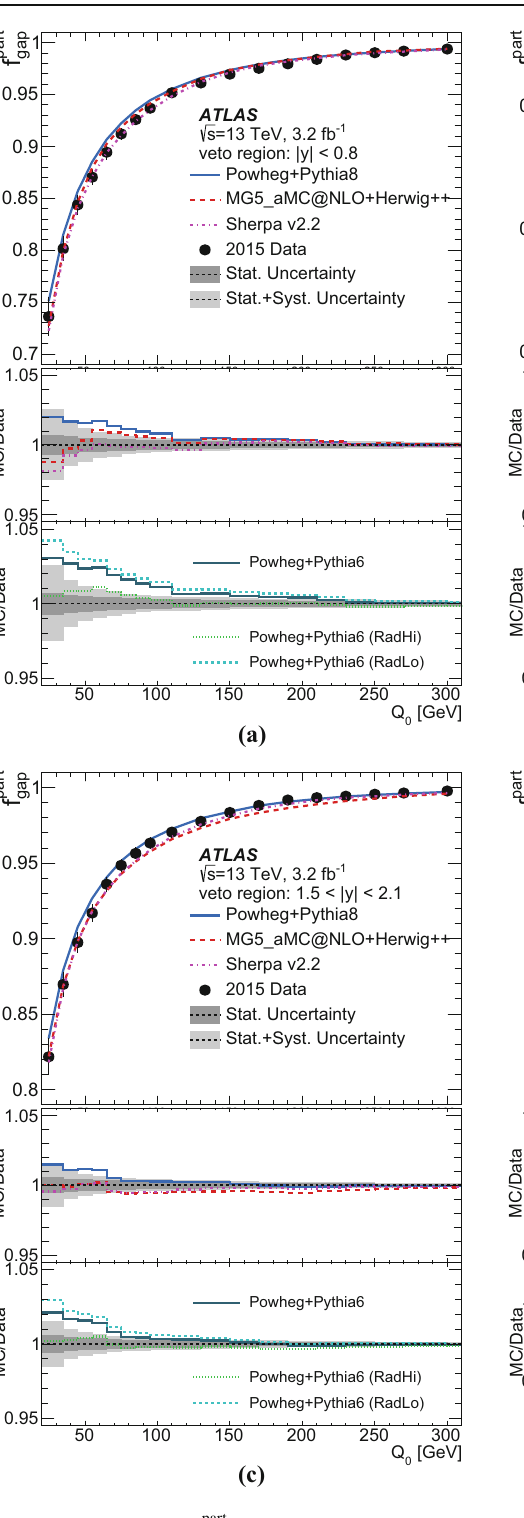
The lower plots show the ratio of predictions to data, with the data uncertainty indicated by the shaded band , and the Q 0 thresholds corre- sponding to the left edges of the histogram bins , except for the first